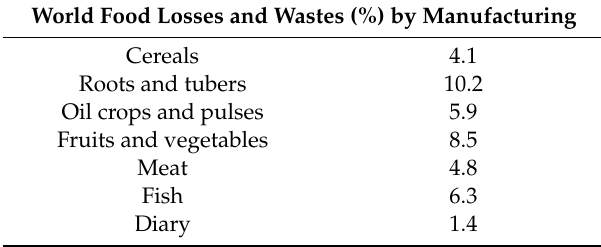
Table 2. Global food losses and food waste (adapted from